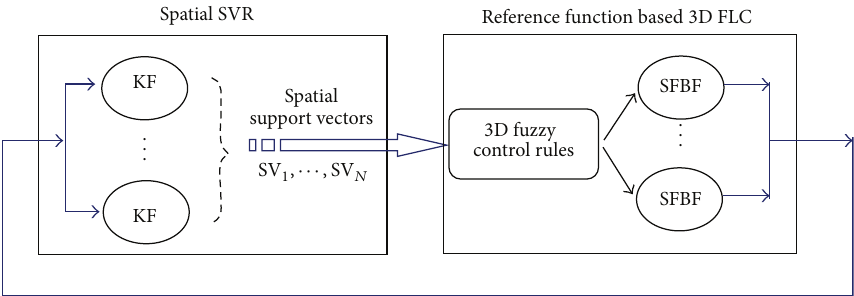
Figure 3: Design methodology of reference function based 3D FLC design using SVR learning.